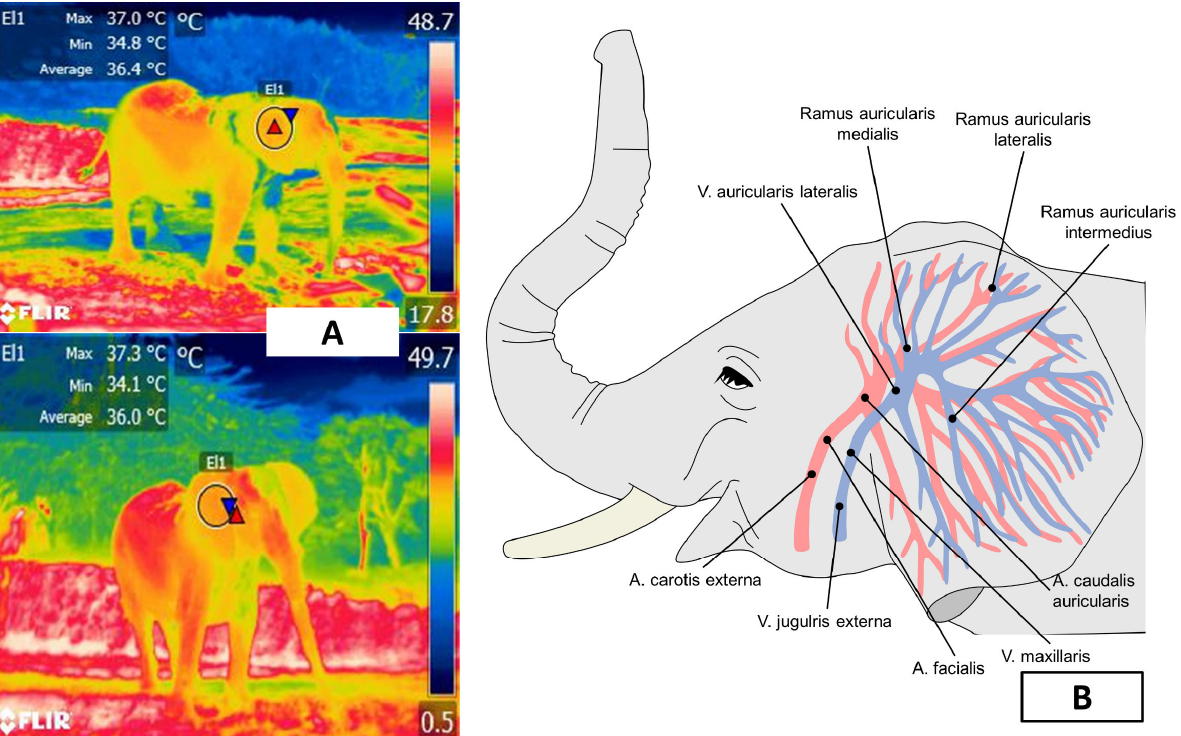
Figure 5. Auricular window of an African elephant ( Loxodonta africana ). ( A ). A circle around the external auditory canal represents the window. ( B ). The blood supply to the ear comes from the branches of the lateral auricular artery and the medial and marginal areas of the ear.